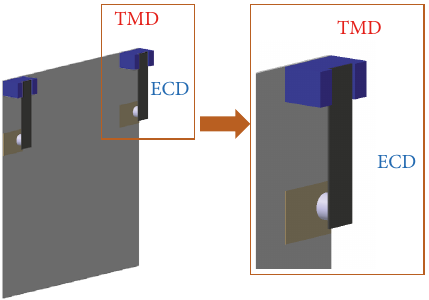
Figure 5: Schematic of magnetically tuned mass